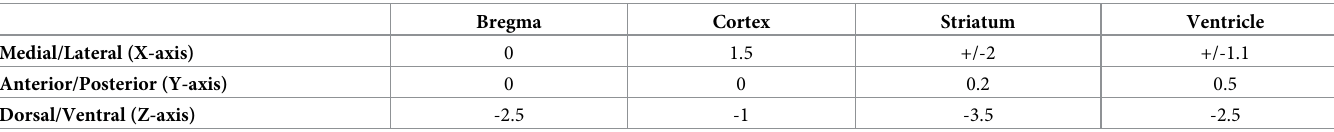
Table 1. Stereotaxic coordinates for C . neoformans intracerebral infection of C57BL/6